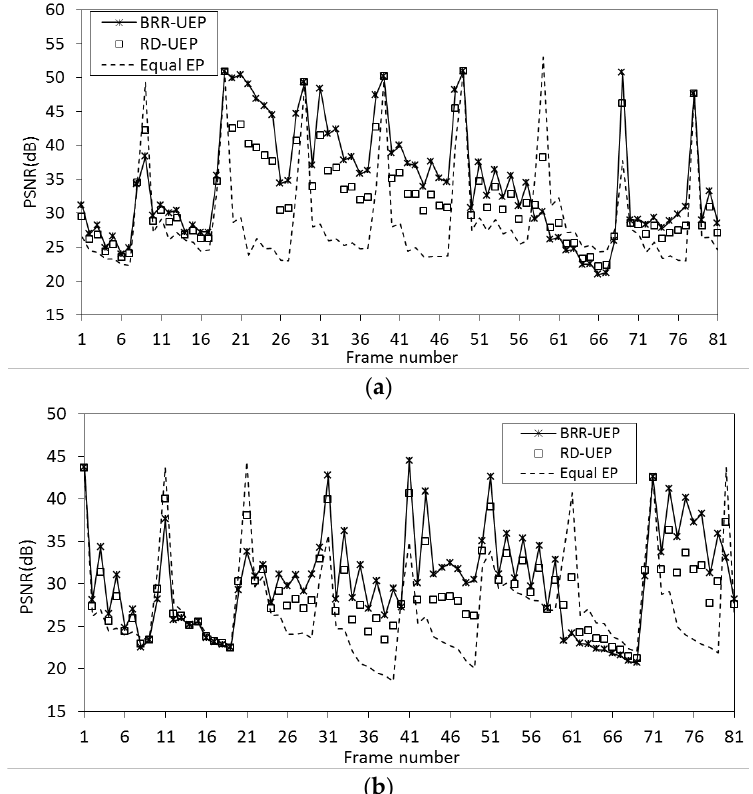
Figure 10. Frame-by-frame PSNR Comparisons of BRR-UEP, RD-UEP, and Equal EP under packet loss rates and test sequences. ( a ) BRR-UEP (34.61dB), RD-UEP (32.55 dB), and Equal EP (28.50 dB) for packet loss rate of 10% in ‘Foreman’; ( b ) BRR-UEP (30.31 dB), RD-UEP (29.01 dB), and Equal EP (27.06 dB) for packet loss rate of 15% in ‘Mobile’.